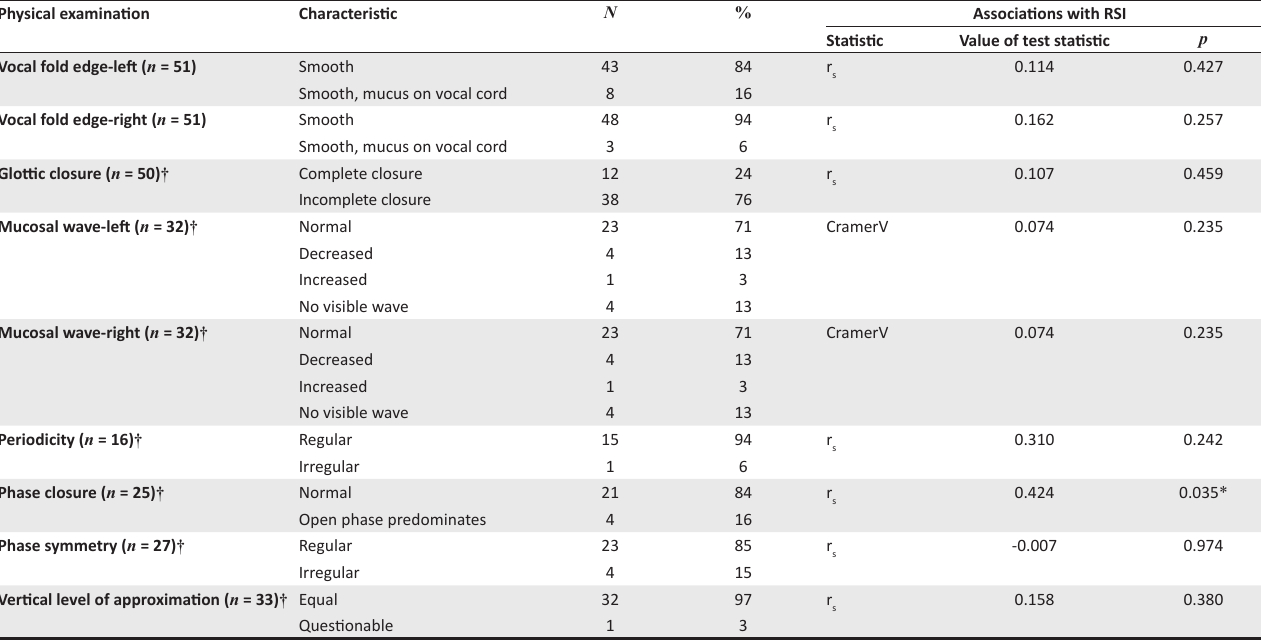
TABLE 5: Associations of RSI with physical vocal characteristics. Physical